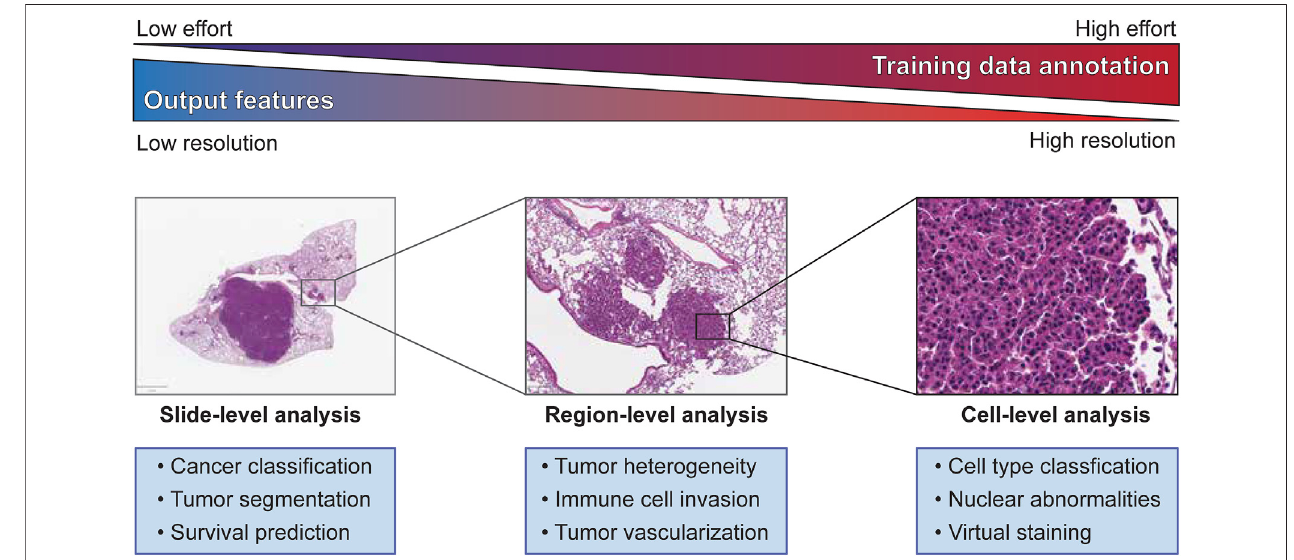
FIGURE 1 | Slide-, Region-, and Cell-level analyses on tumor histopathology images and its